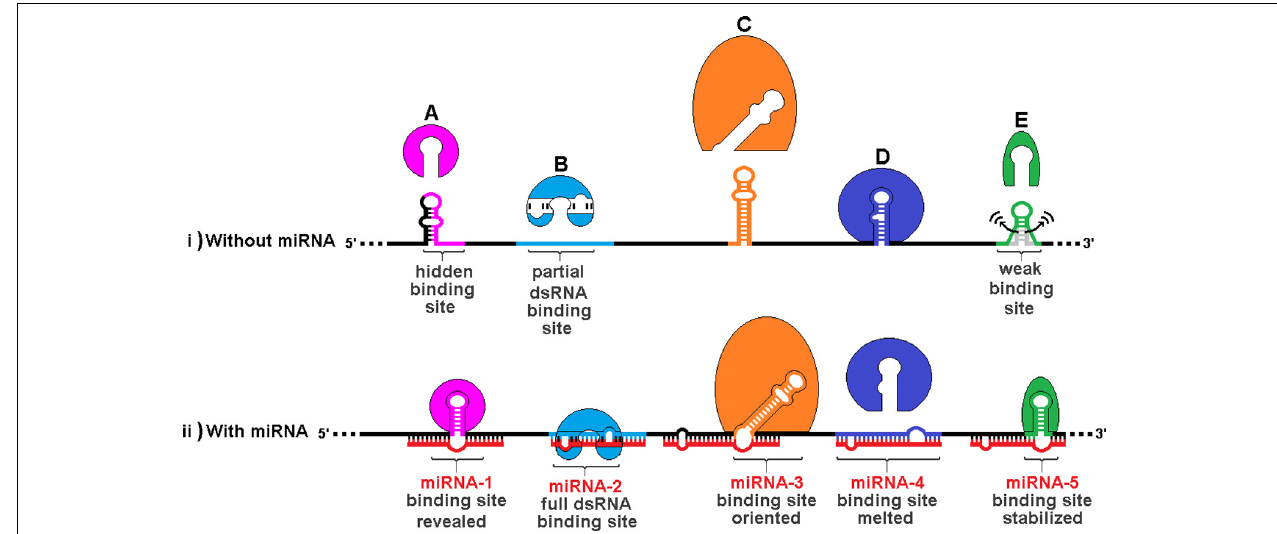
FIGURE 7 | Trans RNA modulation of RNA Binding Protein (RBP) structural binding sites. The same hypothetical mRNA is shown in both (i) without associated miRNAs and (ii) with these miRNAs. A number of different functional mechanisms for trans-acting modulation are depicted: (A) An RBP whose binding site is hidden by an alternate structure. In the presence of the associated trans-acting ncRNA, the site is revealed. (B) An RBP that recognizes a double stranded binding site that only forms via interaction with a separate ncRNA. (C) An RBP whose binding site must be presented in a particular orientation, with respect to its flanking sequence, that is facilitated by a 3WJ. (D) An RBP whose